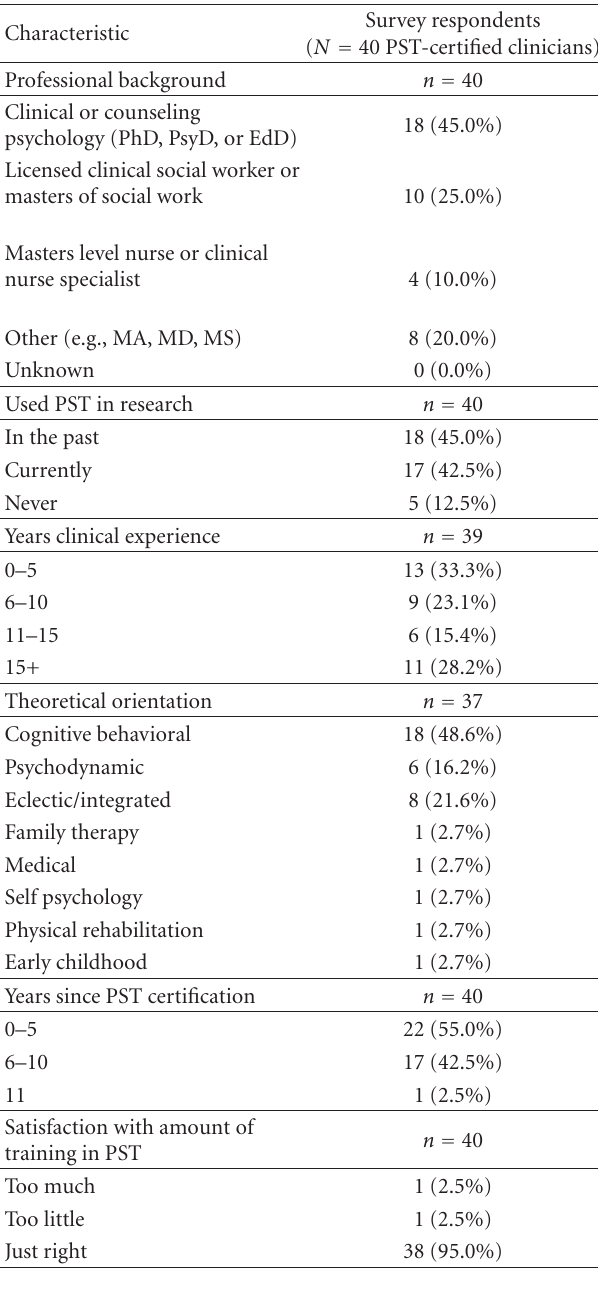
Table 1: Professional background and training in